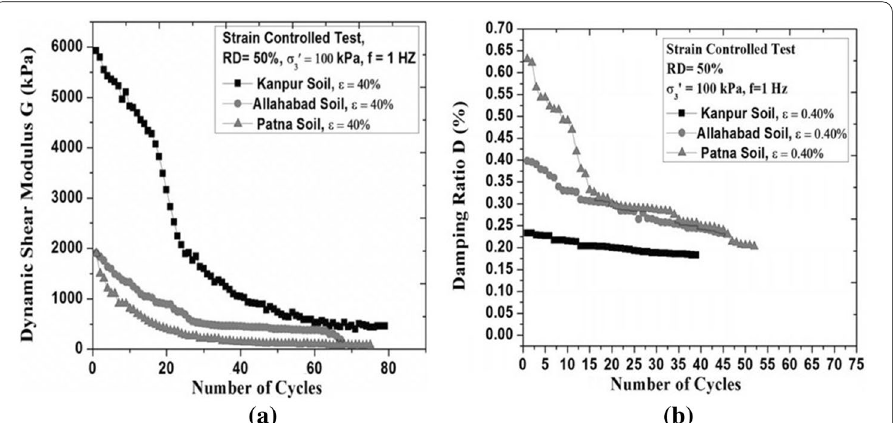
Fig. 11 a Variation of shear modulus with number of cycles for Kanpur, Allahabad and Patna soil (RD frequency 1 Hz, strain amplitude = Patna (RD 50%, effective confining pressure =